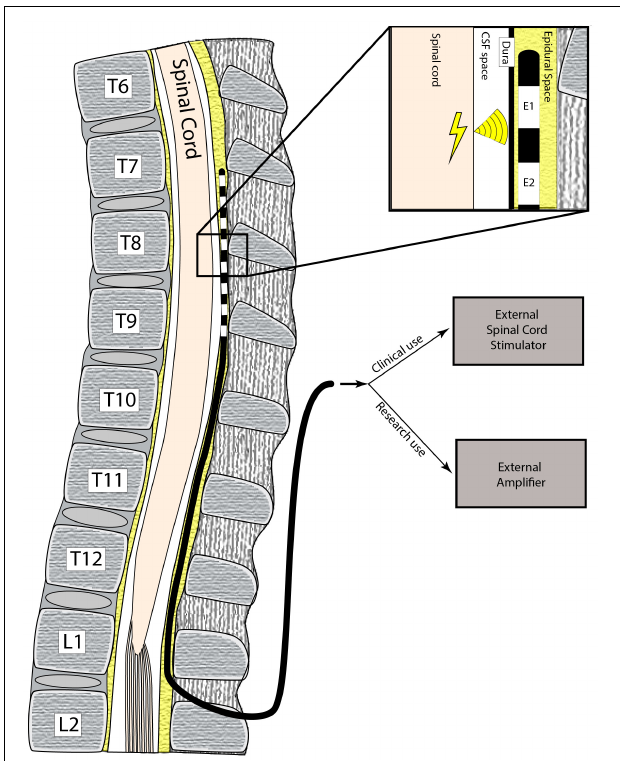
FIGURE 1 | Schematic of electrode implantation. The patient has a surgical procedure to implant electrodes in the epidural space, which are used to record electrical impulses from the spinal cord. These electrodes exit the skin and are connected to the recording adapters and hardware to obtain SEG